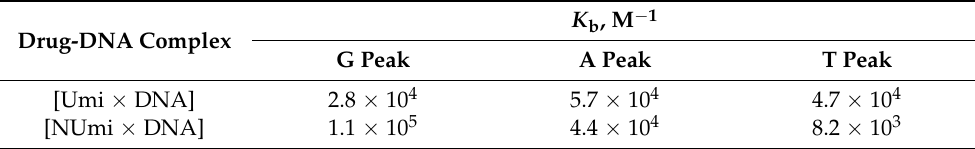
Table 3. Values of binding constants ( K b ) of Umi or NUmi with dsDNA complex calculated from the results of DPV analysis.